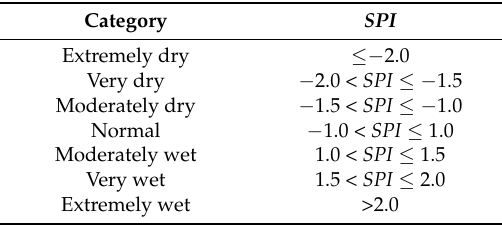
Table 1. Precipitation categories according to SPI.